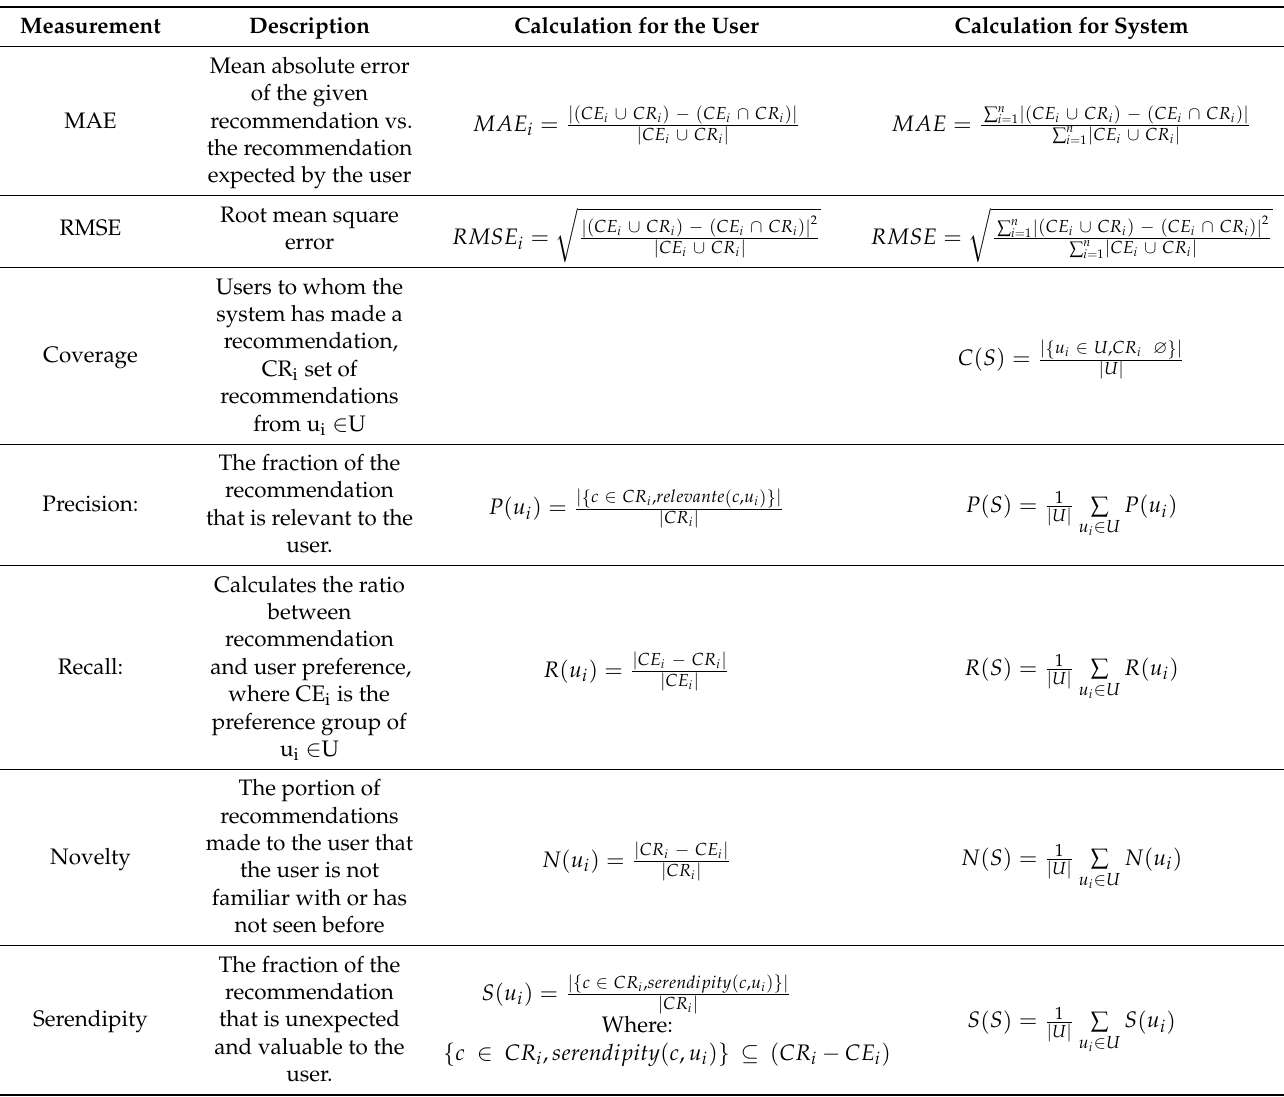
Table 2. Recommendation System evaluation